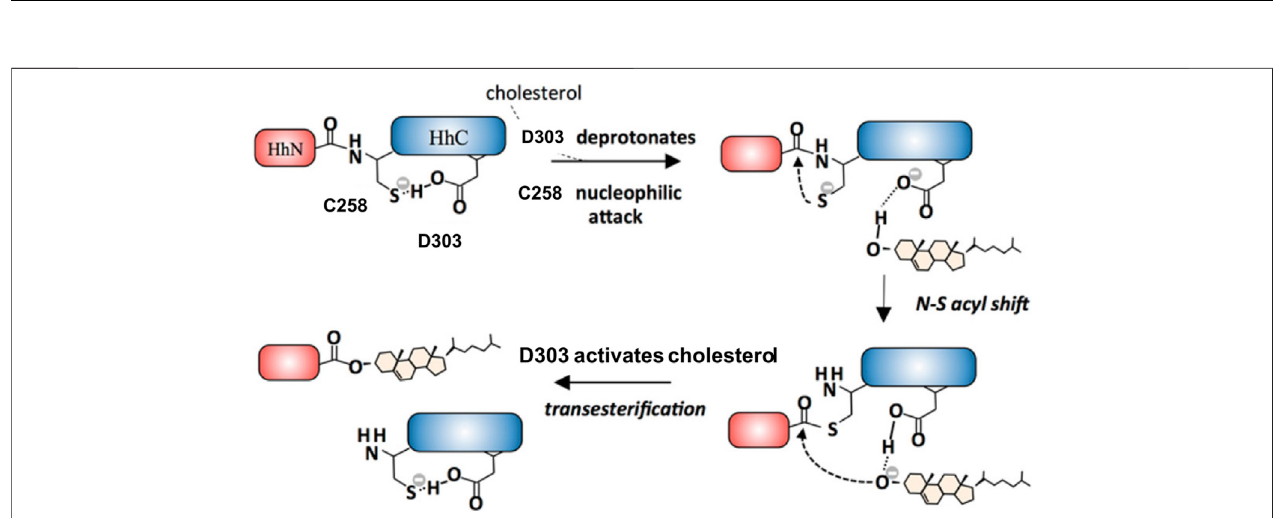
FIGURE5| D303coordinatestwokeystepsofHhautoprocessing.CoordinationmechanismoftwokeystepsofHhautoprocessingbyconservedD303residuein Hint. Figure from the reference, Xie et al. (Xie et al., 2016) with permission.